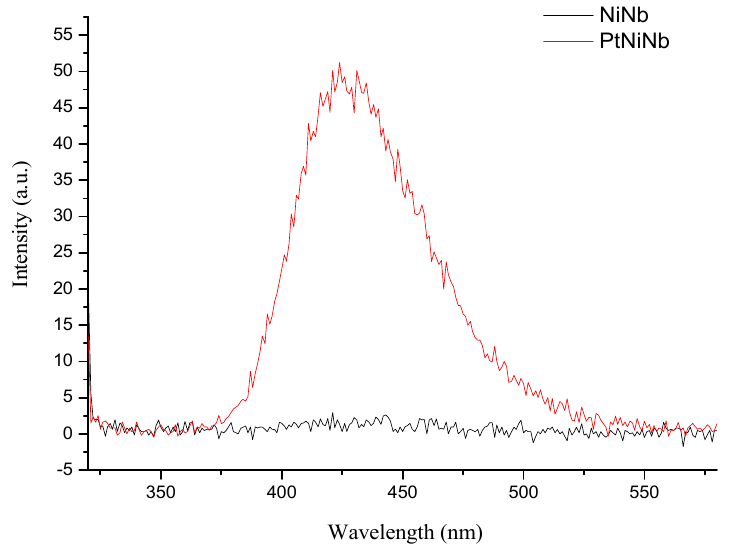
Figure 10. Fluorescence spectrum of 2–HTA after the photocatalysis. Black line shows the result